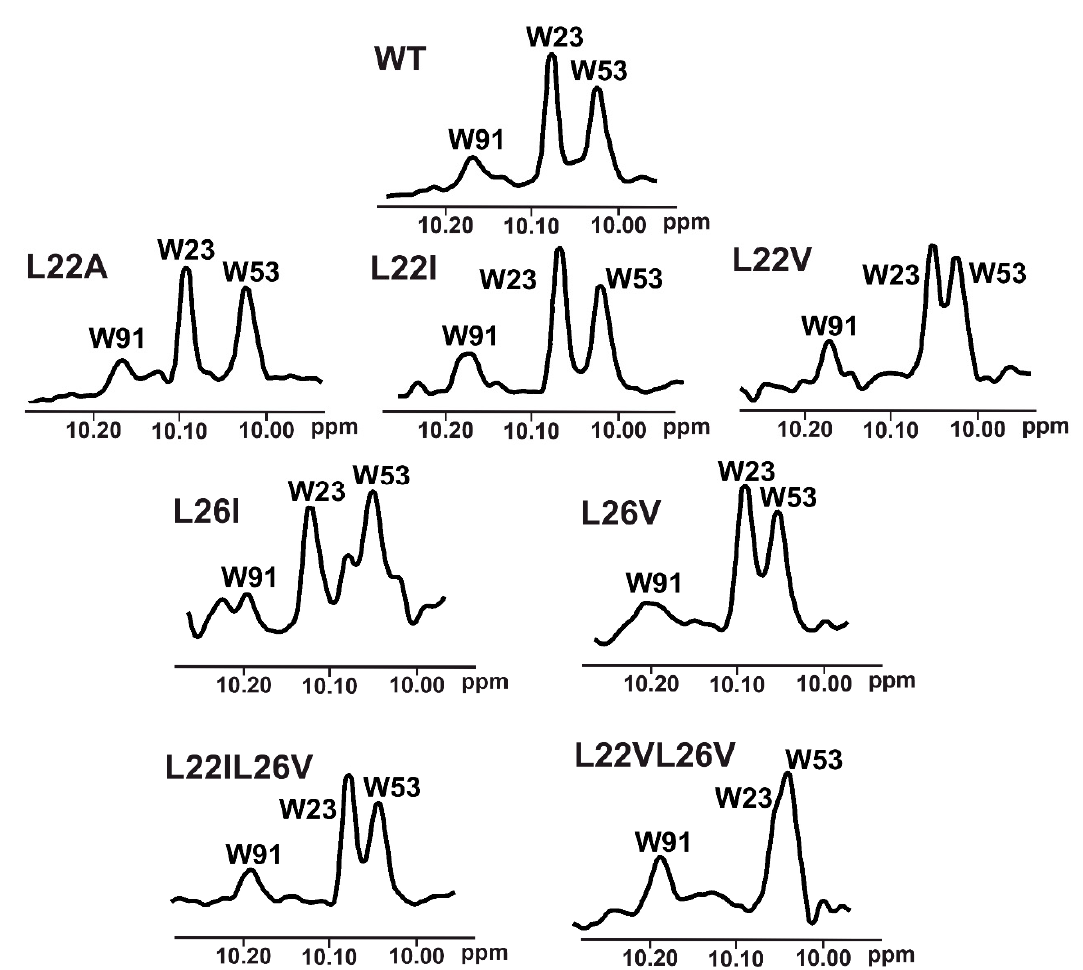
Figure 4. An enlarged part of the 1 H-NMR spectrum of wt-p53 and its mutants. Visible peaks originate from the side chain N H ε protons of W91, W23, and W53 left to right, respectively.